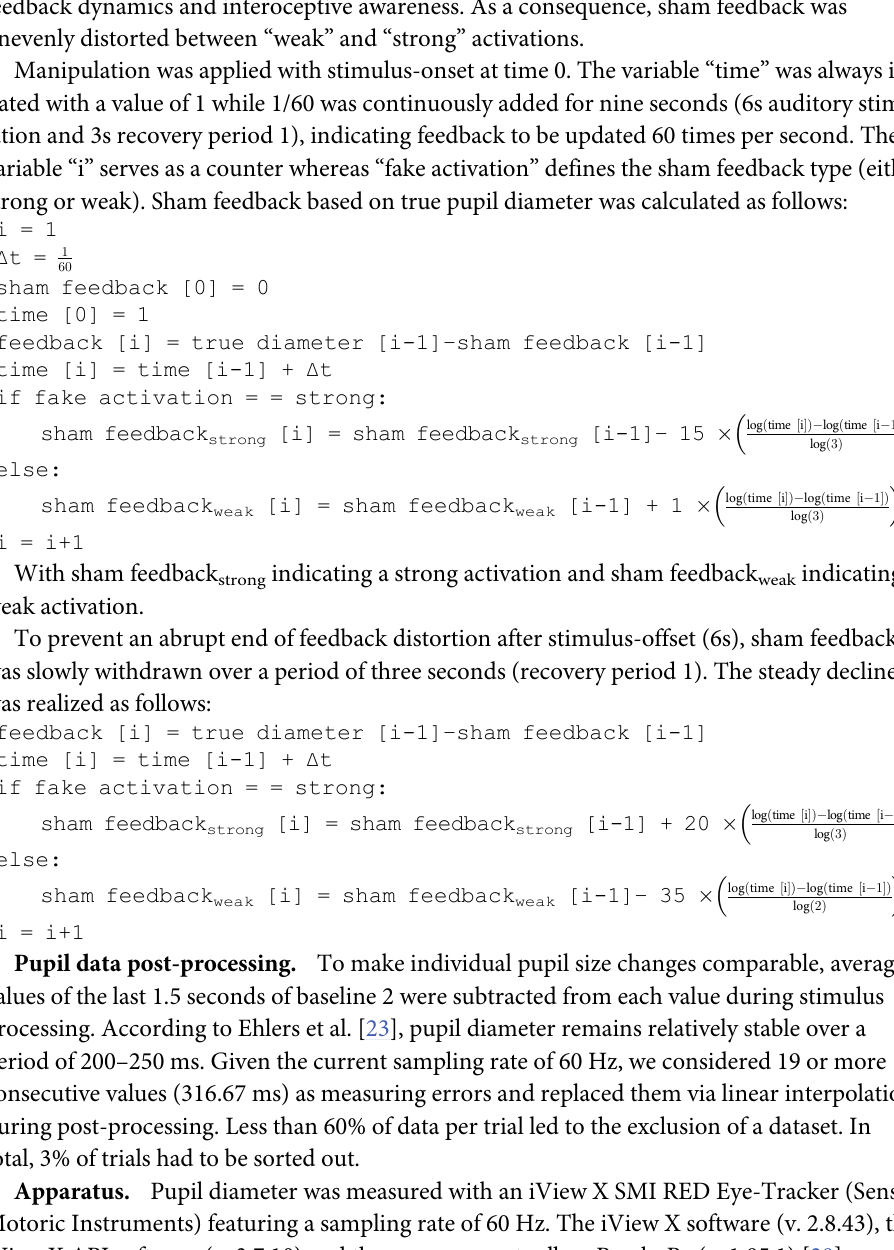
Apparatus. Pupil diameter was measured with an iView X SMI RED Eye-Tracker (Senso- Motoric Instruments) featuring a sampling rate of 60 Hz. The iView X software (v. 2.8.43), the iView X API software (v. 3.7.10) and the open source toolbox PsychoPy (v. 1.85.1) [28] were applied for real-time visualization, data recording and storage. Feedback was displayed on